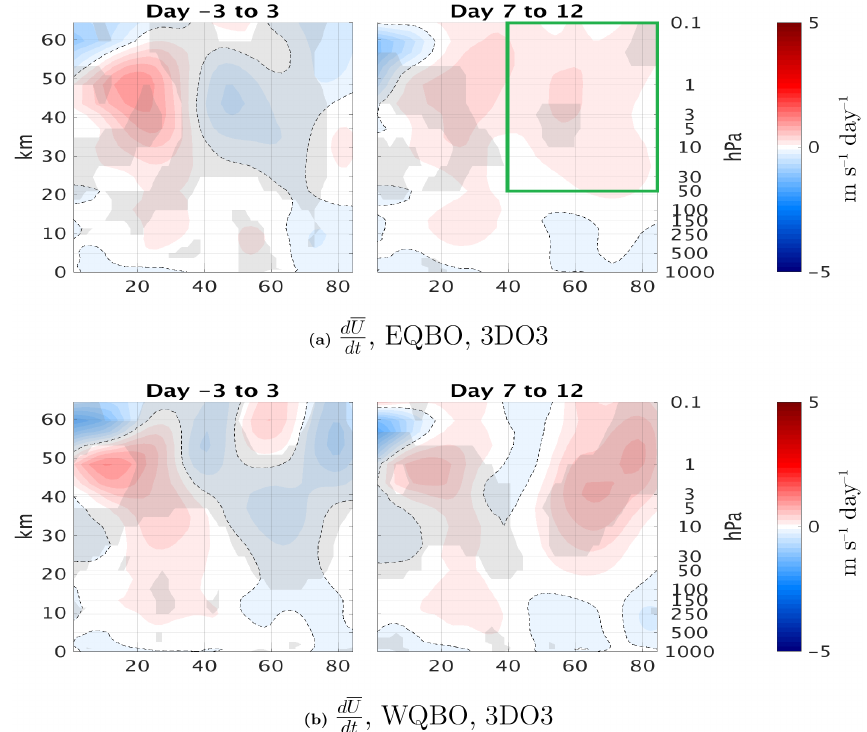
Figure 7. Time lag composite of the zonal mean zonal wind time tendency for east QBO (a) and west QBO (b) for the positive heat flux events from the 3DO 3 run of October. The green box in row (a) shows the area of averaging for Fig.